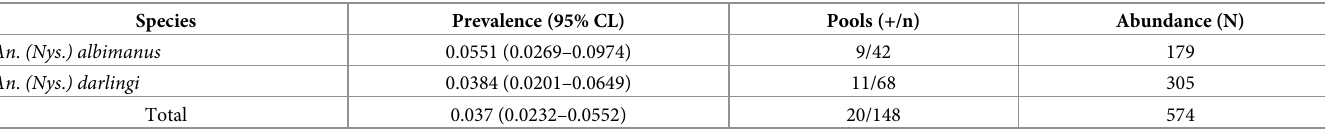
Table 5. Plasmodium vivax prevalence and positive pool numbers from An . (Nys . ) albimanus and An . (Nys . ) darlingi mosquitoes collected in Darien, Panama. Species